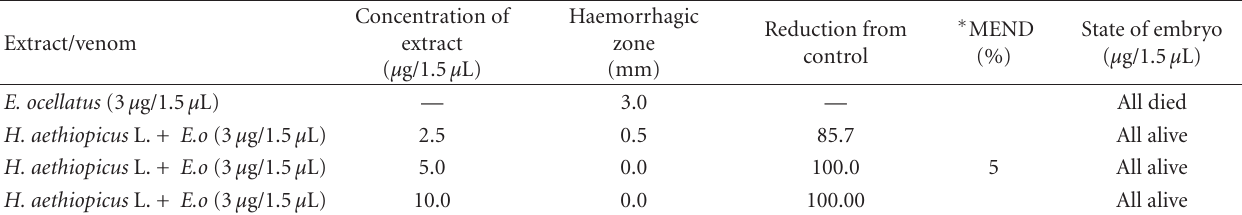
Table 1: E ff ects of H. aethiopicus L. extract on the haemorrhage induced by E. ocellatus venom in the egg embryo. Extract/venom